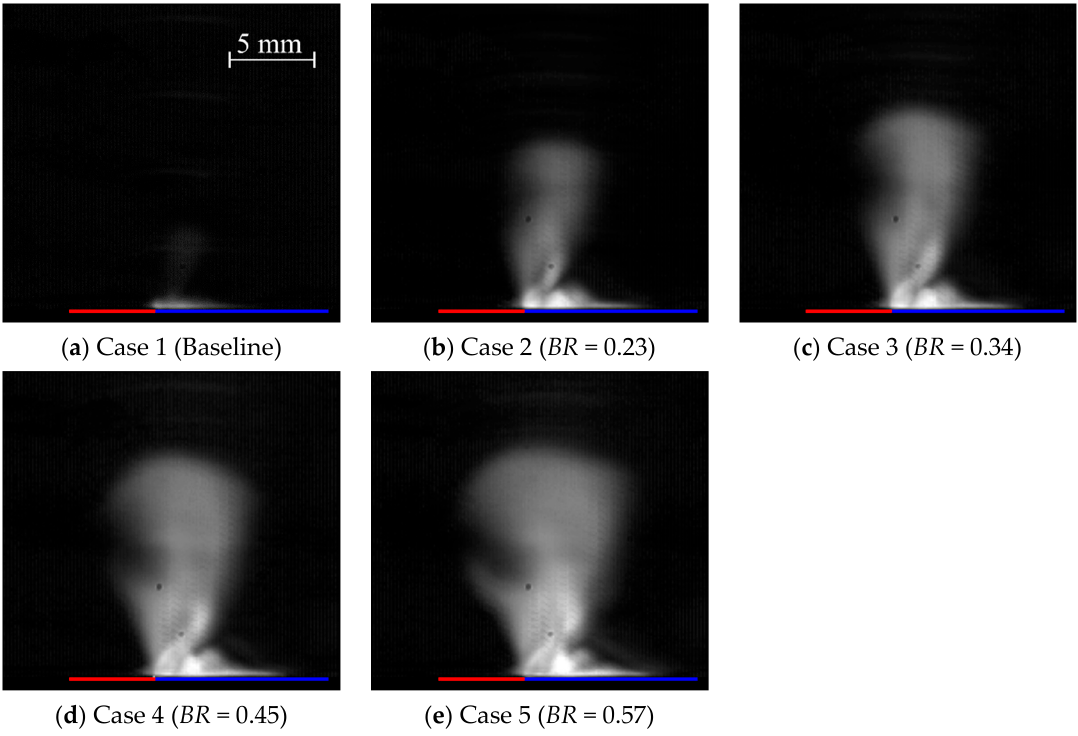
Figure 9. The RMS Schlieren images (the RMS is obtained by the images during the nine burst events).